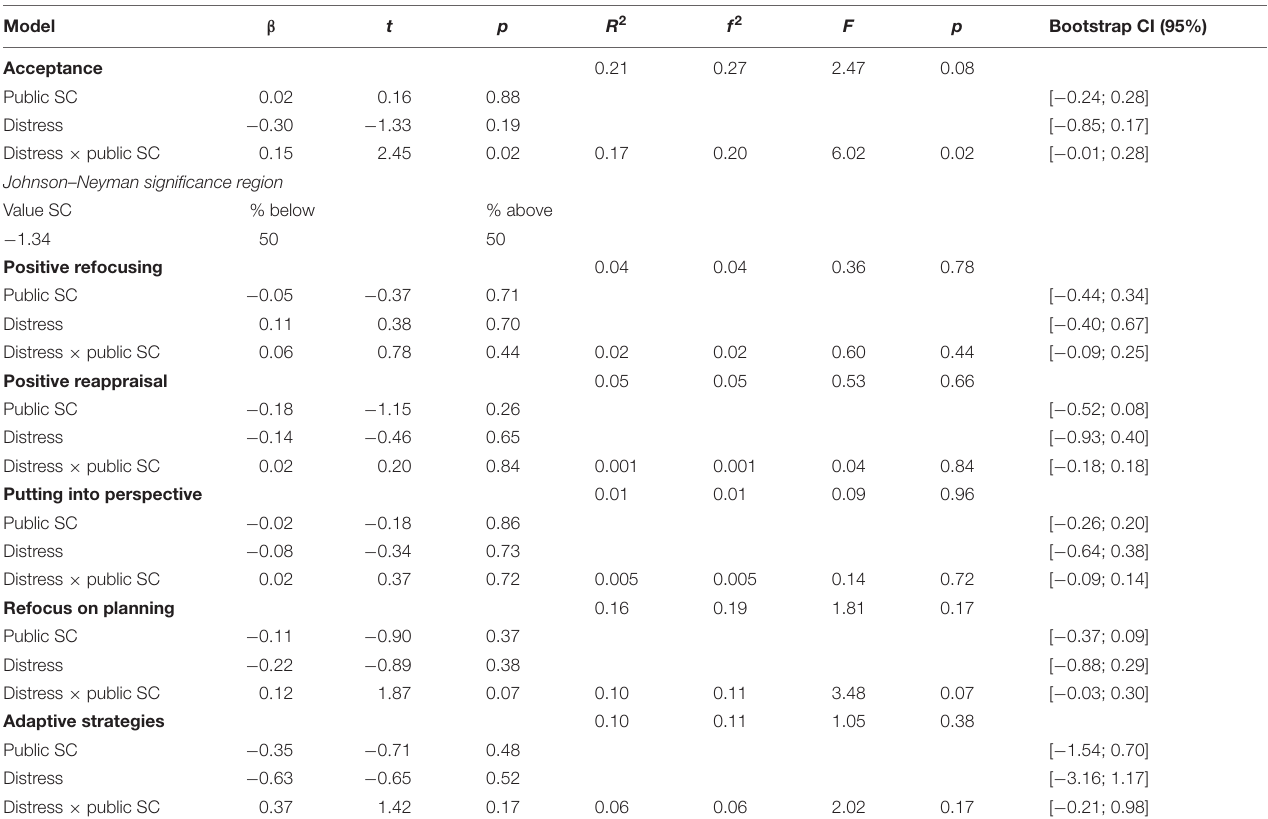
TABLE 6 | Multiple regression analyses predicting adaptive emotion regulation strategies as a function of public SC, distress and their interaction in the binge drinking group.